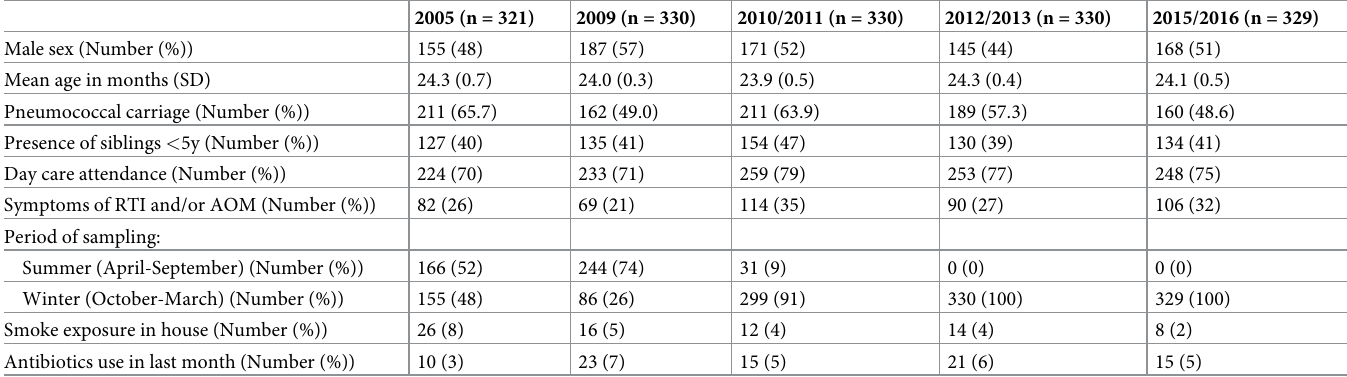
Table 1. Characteristics of the 24-month-old children of all five